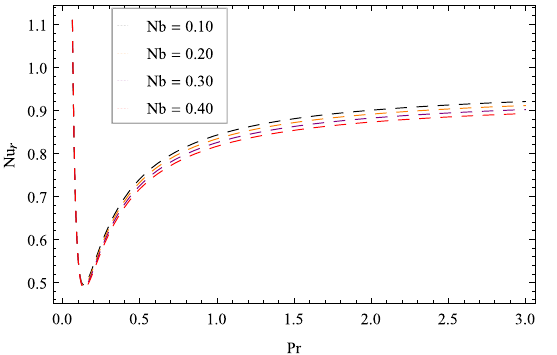
Figure 26. Pattern of graph curves on account of Nb .